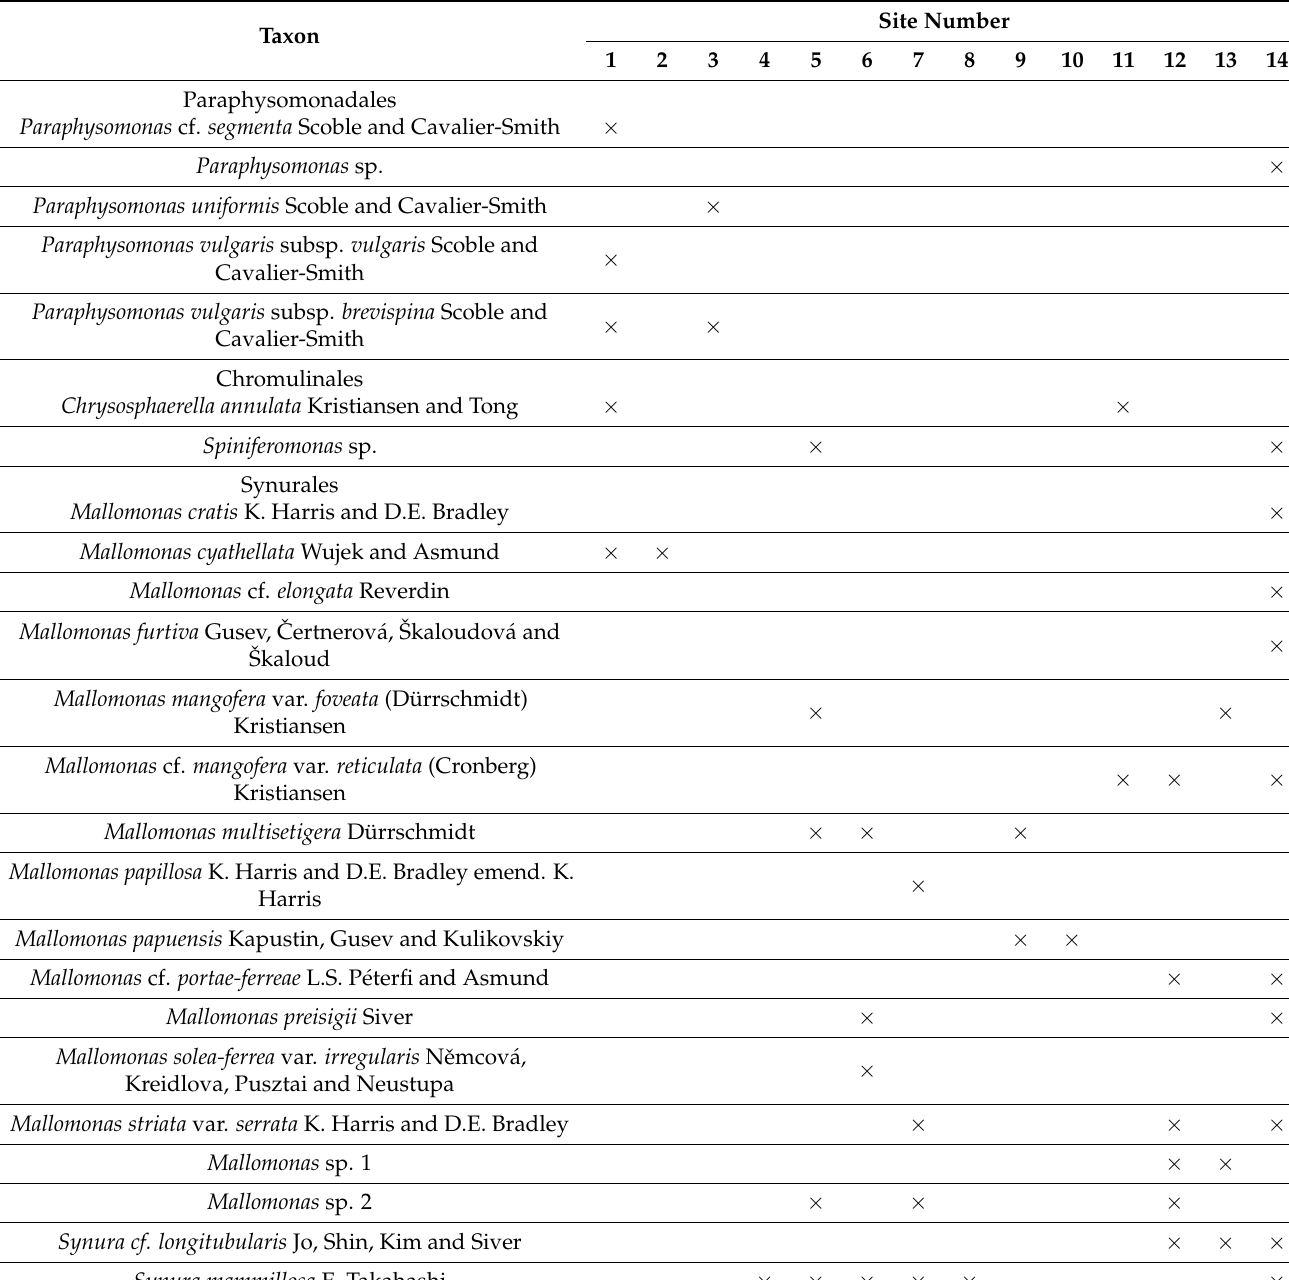
Table 2. List of taxa observed at the investigated waterbodies (new taxa for Indonesia are in bold).